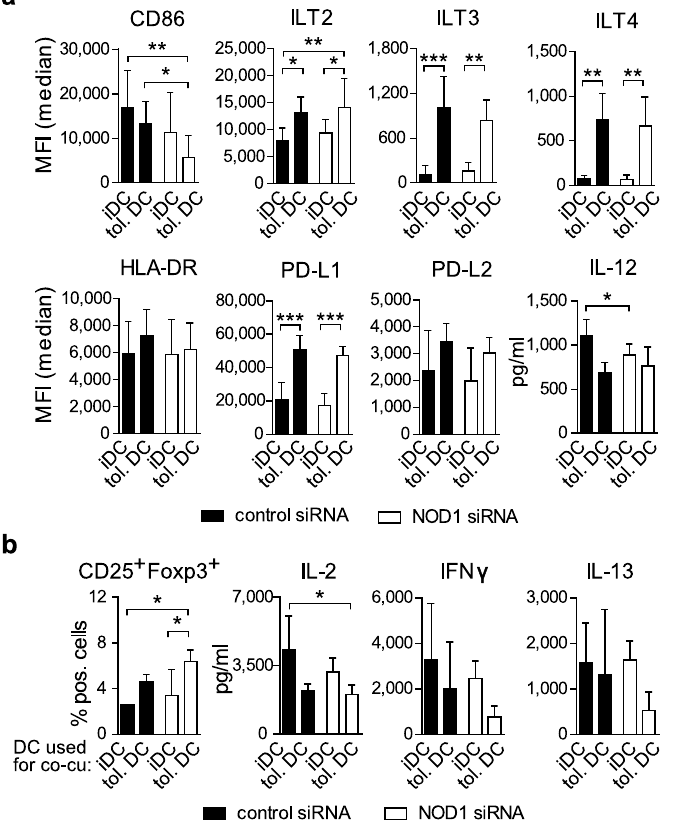
Figure 2. NOD1 silencing promotes a tolerogenic DC phenotype. ( a ) To obtain tolerogenic DCs (tol. DC), iDCs were differentiated in the presence of IL-10 (30 ng/ml) for 7 days. Fully differentiated tolerogenic DCs and conventional iDCs (differentiated in the absence of IL-10) were silenced with control or NOD1 siRNA for 72 hours. ILT2, ILT3, ILT4, HLA-DR, CD86, PD-L1 and PD-L2 were analysed by flow cytometry. IL-12 secretion was monitored by ELISA. Data represent mean and SD of at least three independent experiments. ( b ) iDCs or tolerogenic DCs were co-cultured (co-cu) with naïve, allogeneic CD4 + T-cells. After 12 days of co- culture, only T-cells were re-stimulated with anti-CD3/PMA for 48 hours, and CD25 and FOXP3 expression was analysed by flow cytometry, and IL-2, IFN- γ and IL-13 secretion was measured by multiplex assay. Lymphocytes were gated on live, CD3 + , CD4 + cells after doublet exclusion. Data represent mean and SD of three